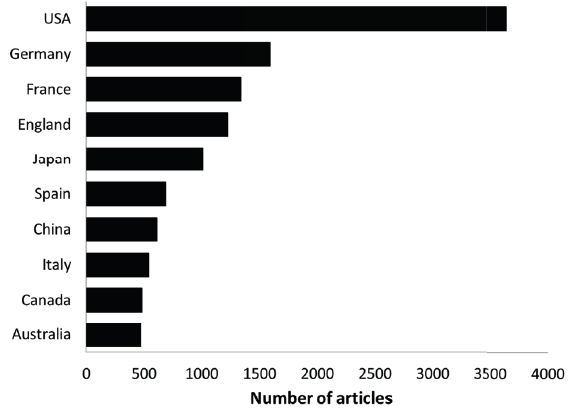
Figure 2 - Number of articles published between 1987 and 2016 by the 10 most productive countries. The sum of the number of articles published by the countries will be higher than the total number of articles because many articles are published by authors from diff erent countries.